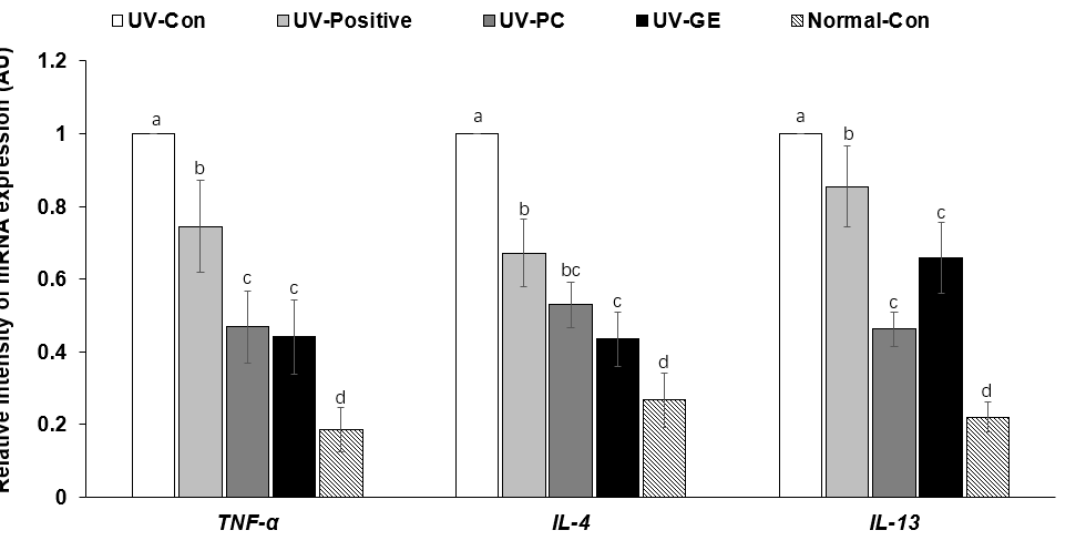
Figure 4. mRNA expression levels of proinflammatory cytokines in the dorsal skin. Each value represents the mean ± SD of 5 mice randomly selected from each group. AU, arbitrary unit. a,b,c,d Means with different superscripts were significantly different among the groups in each parameter by the Tukey test at p < 0.05.